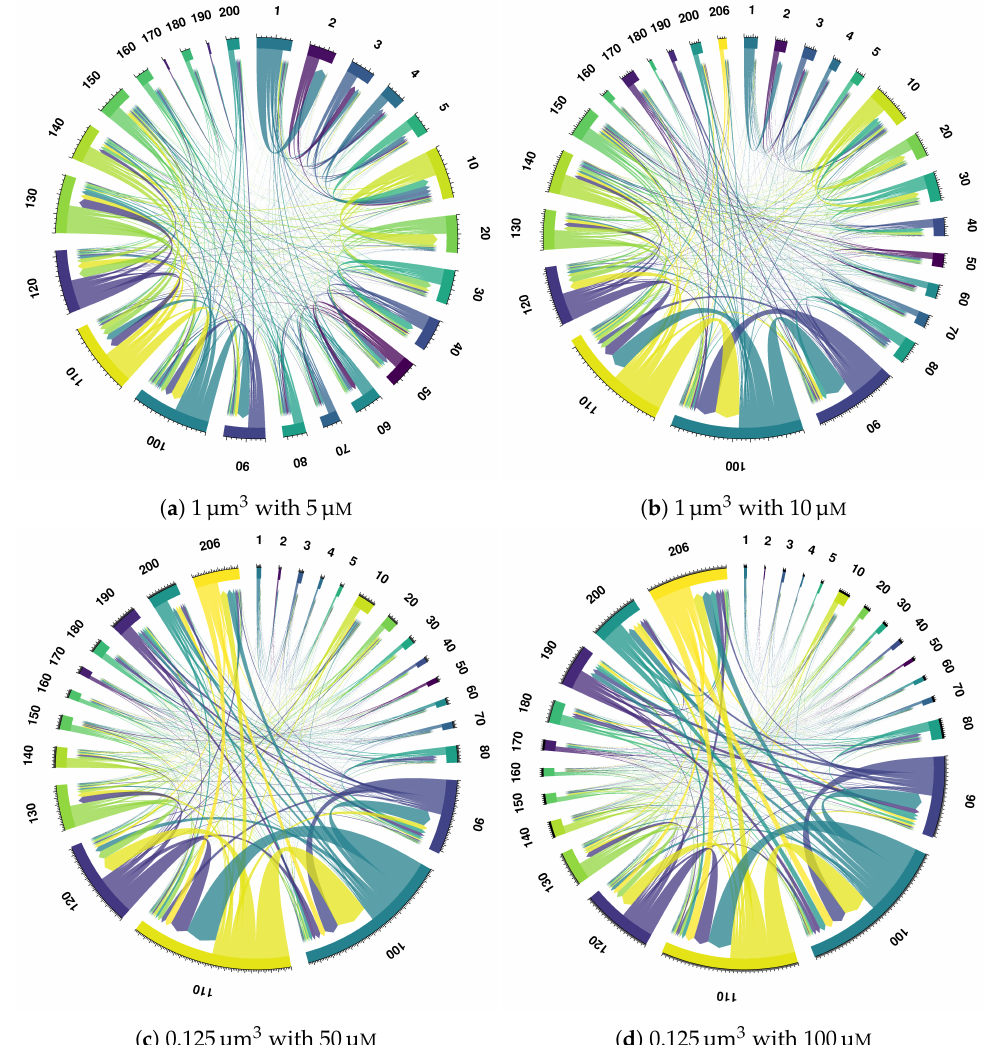
Figure 16. Self-assembly by bi-directional transitions between size classes normalized by total number of dimers (major ticks represent unit arrow thickness, i.e., every dimer makes this transition on average). Starting at class 10, the size denotes the class range between − 4 to +5 relative to the noted value; 206 incorporates all sizes equal to or larger than 206. Colors provide contrast only.